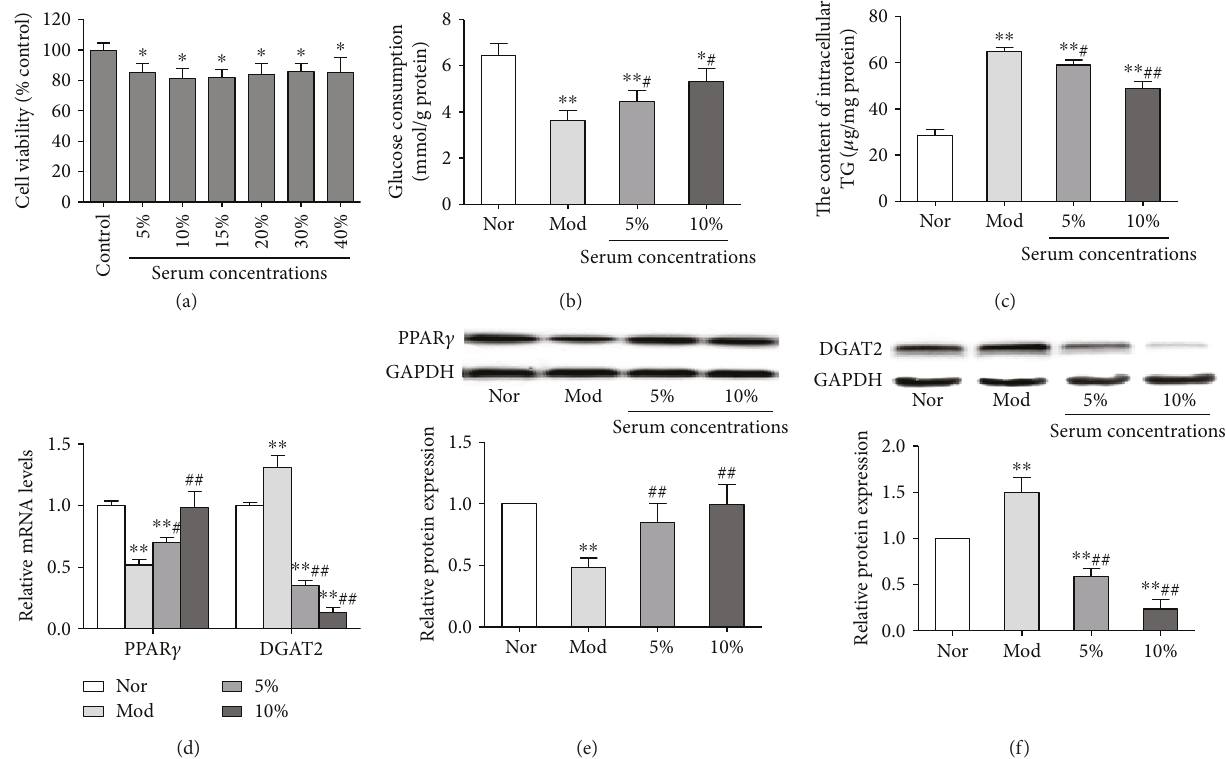
Figure 4: E ff ects of TDQ on palmitate-induced hepatocellular model of insulin resistance. (a) Cell viability of HepG2 cells treated with di ff erent concentrations of TDQ-containing serum. (b, c) Glucose consumption and intracellular TG were analyzed in TDQ-treated HepG2 cells. (d, f) mRNA and protein levels of PPAR γ and DGAT2 in palmitate-induced insulin resistance in HepG2 cells. Data are presented as the mean ± SD . ∗ P < 0 05 and ∗∗ P < 0 01 vs. Nor; # P < 0 05 and ## P < 0 01 vs.